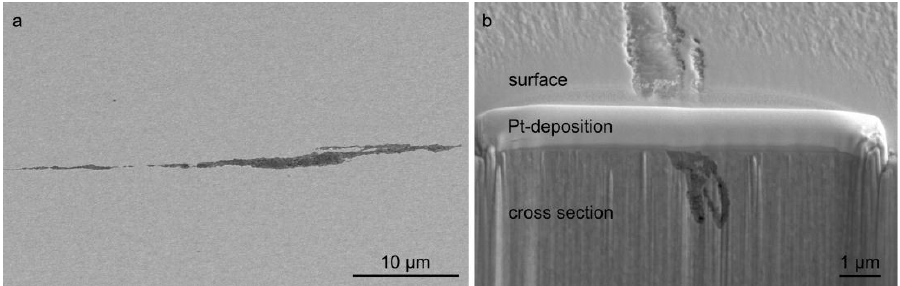
Figure 5. SEM images of a sheared non-metallic inclusion on the (non-etched) surface of t-HPT-10: ( a ) top view; ( b ) FIB cut through the